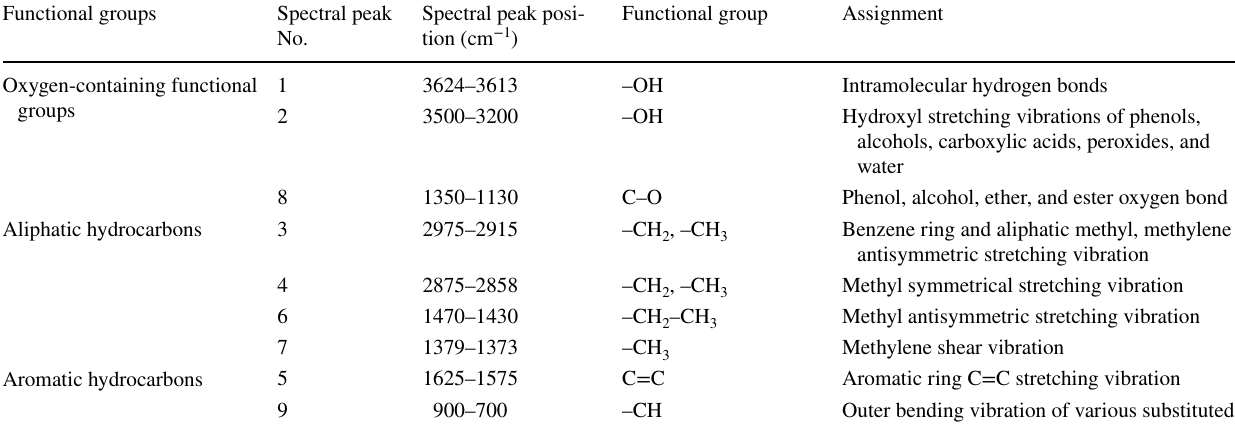
Table 2 Characteristics of absorption peaks for the coal samples Functional groups